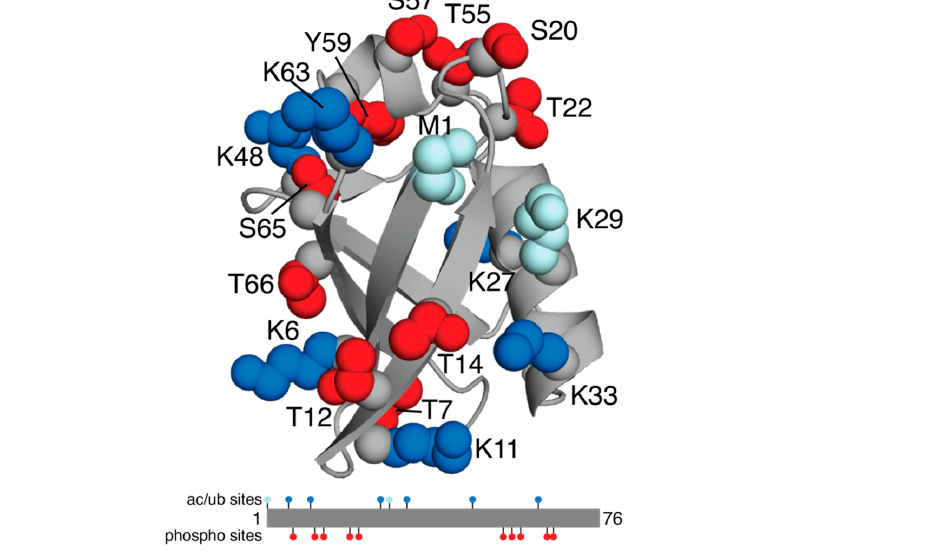
Figure 1. Ubiquitin post-translational modifications. The cartoon structure of Ub (PDB 1UBQ) [91] is shown in grey with PTM sites indicated: ubiquitination only (pale blue), acetylation or ubiquitination (blue), and phosphorylation (red). Also shown is the linear structure of Ub with the PTMs. All serine (S20, S57, S65) residues, six of seven threonine (T7, T12, T14, T22, T55, T66) residues and the single tyrosine (Y59) have been identified as phosphorylation sites in Ub.